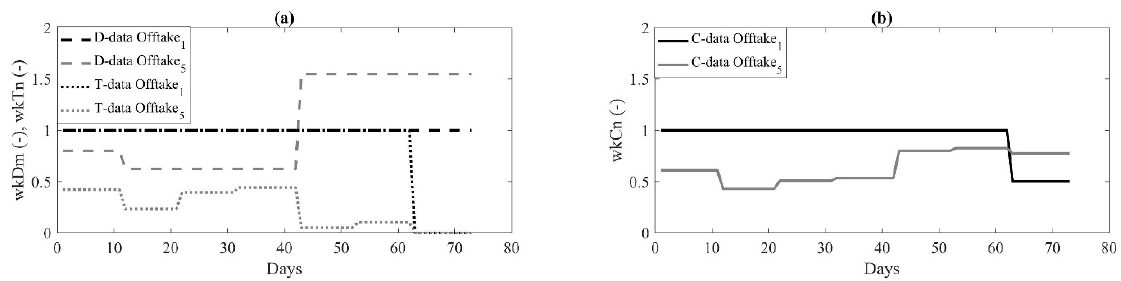
Figure 6. For the year 2015, the values of the weights w kDm and w kTn ( a ) and w kCn ( b ) for the reference offtake (Offtake 1 ) and for a generic one (Offtake 5 ).